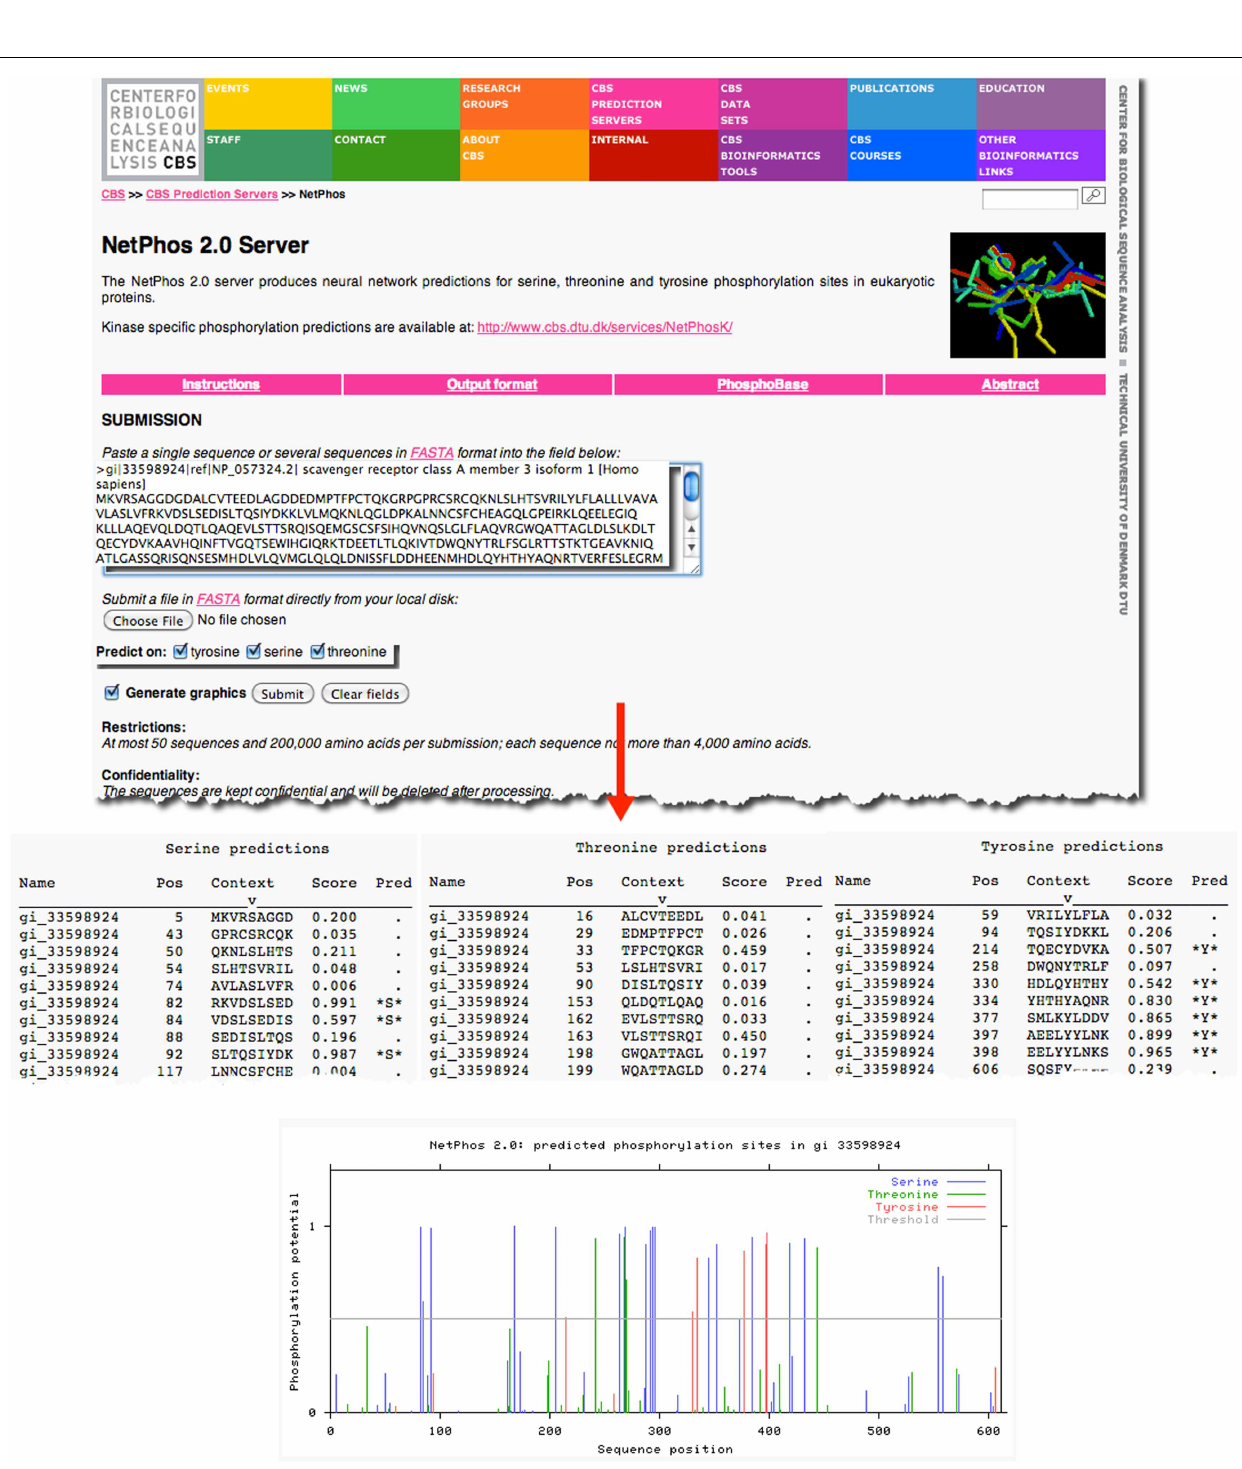
FIGURE 2 | Prediction of post-translational modifications in SCARA3 .The FASTA formatted sequence of SCARA3 from Homo sapiens was entered into the NetPhos 2.0 Server to predict serine (S), threonine (T), and tyrosine (Y) residues that may be phosphorylated. Each instance of these residues and surrounding sequences are displayed under the “ Context ” column. Scores